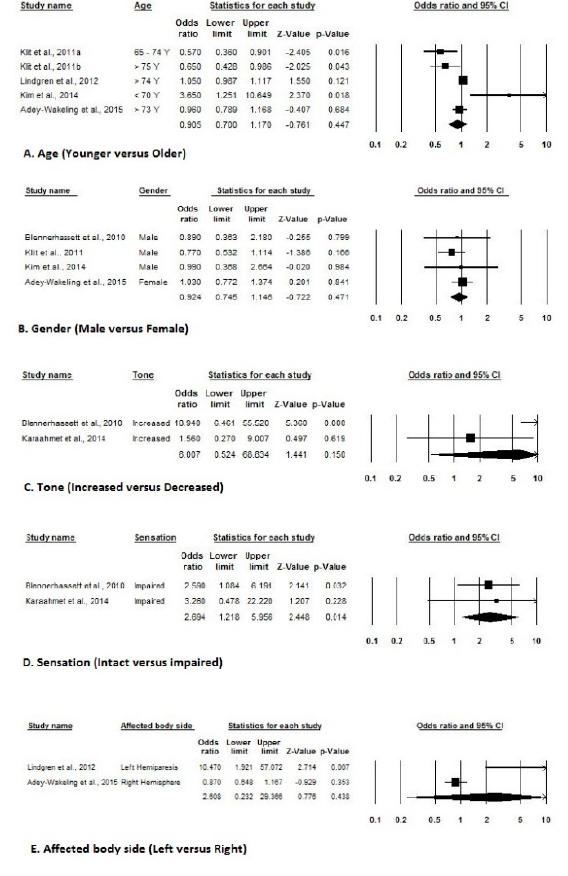
Figure 4. Demographic risk factors for shoulder pain after stroke (( A ). Age, ( B ). Gender, ( C ). Table 5. Clinical risk factors for shoulder pain after stroke (( A ). Types of stroke, (B). Hemispatial neglect, ( C ). Past medical history, ( D ). National Institutes of Health Stroke Scale-NIHSS Score).